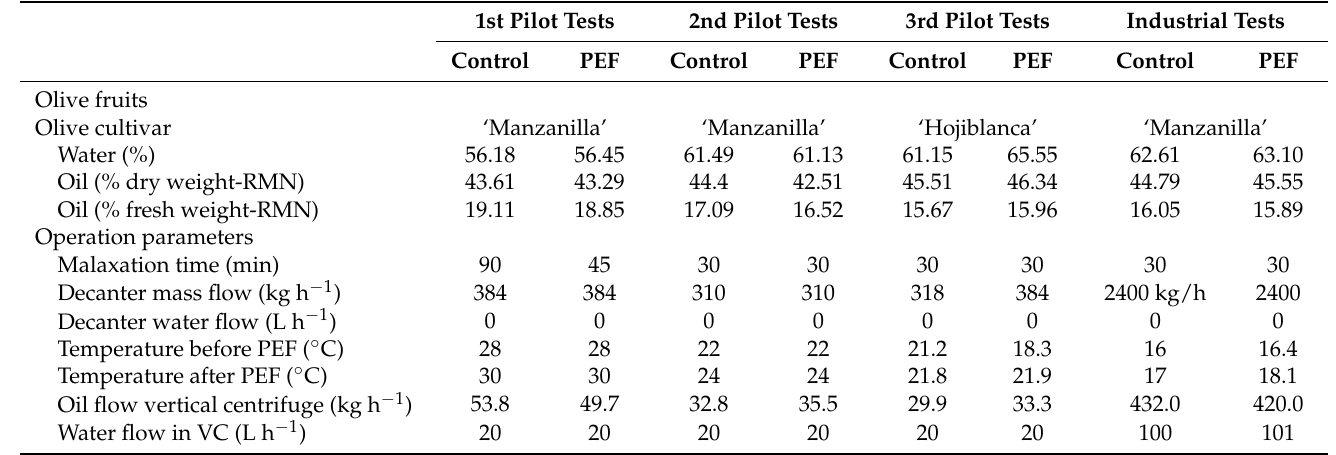
Table 1. Content of water and oil of olive fruits and operating parameters for the extraction trials conducted with fruits of cultivars ‘Manzanilla’ and ‘Hojiblanca’ extracted with a standard protocol (Control) and by applying pulsed electric field (PEF)